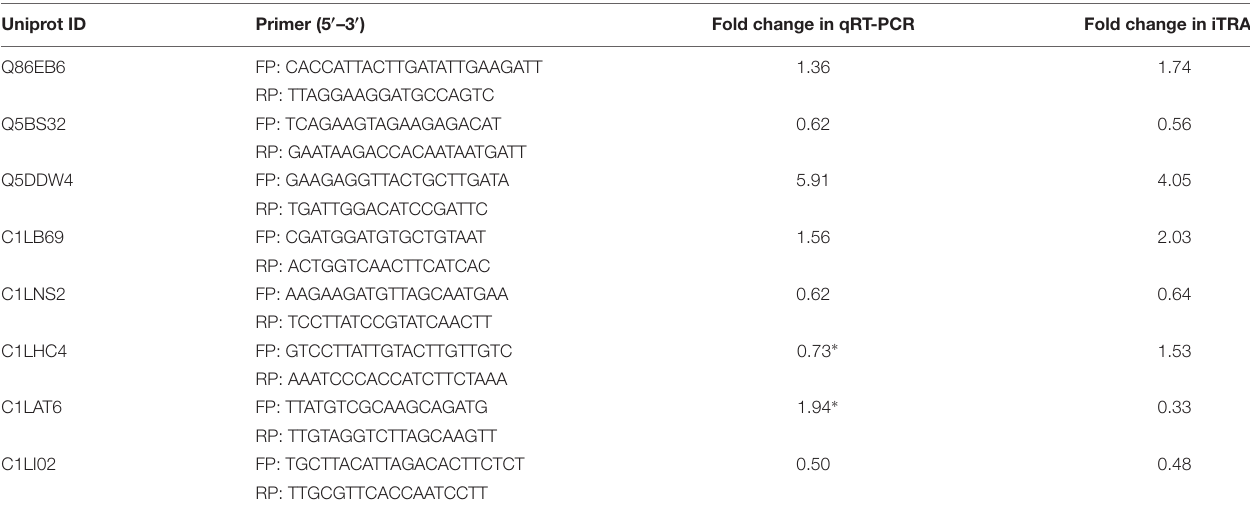
TABLE 1 | qRT-PCR primers and the comparison of the results between iTRAQ and qRT-PCR. Uniprot